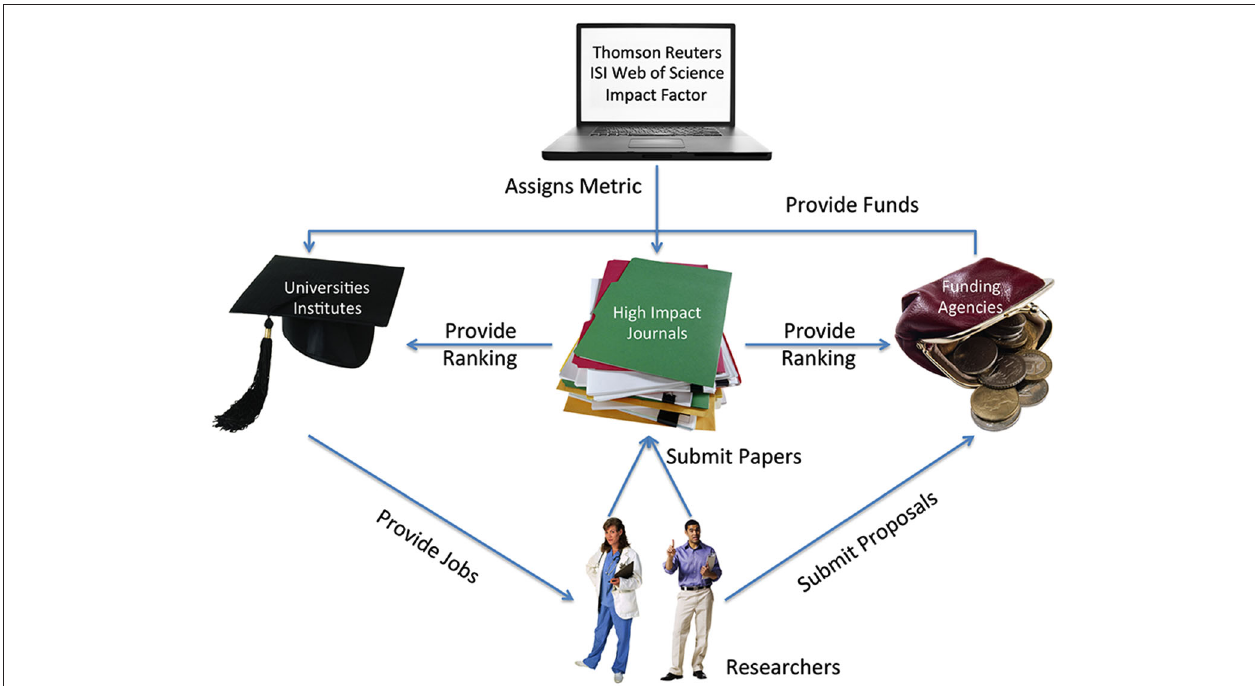
librarians. It is used by knowledge and funding institutions to assess scientists’ quality, because it seems to meet the needs of a standardized, easily comparable, and objective way of assessing research and researchers. Many scholars believe that this incentive system negatively influences decisions of scientists, particularly young scholars competing for tenured positions. Figure created using Microsoft (cid:114) Clip Art. Used with permission from Microsoft